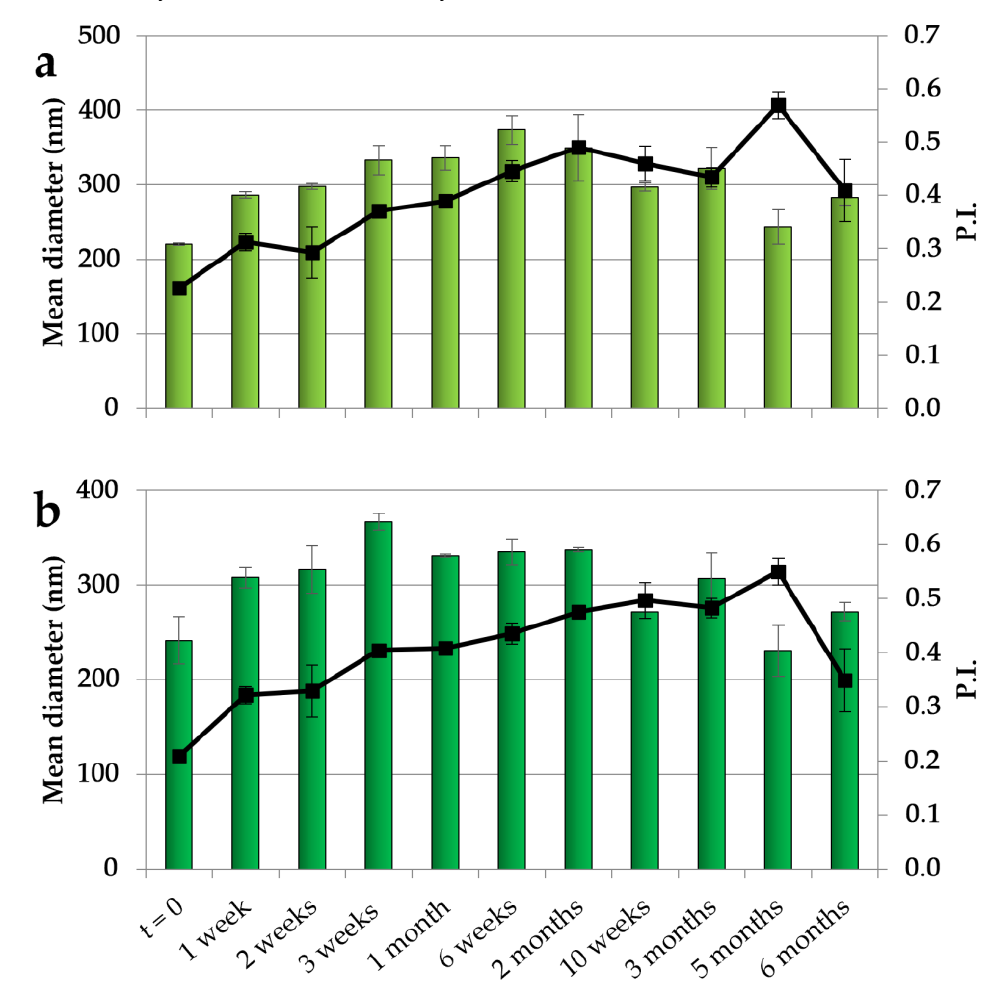
Figure 1. Dimensions (histogram bars) and PI (black symbols) of CSO–CO 50 ( a ) and CSO–CO 100 ( b ) NEs at different times of storage (4 °C) (mean ± sd; n = 3).